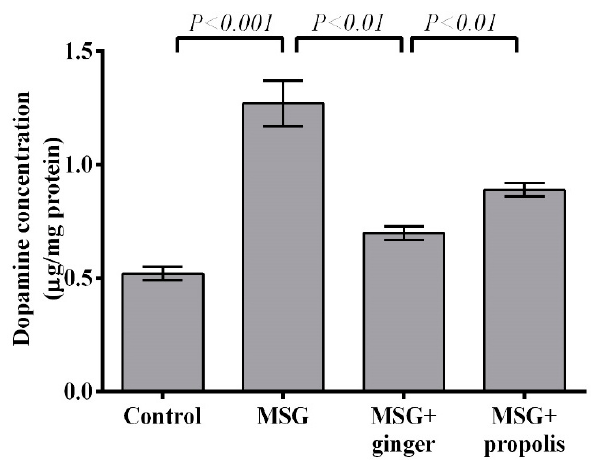
Figure 13. Cerebral cortex dopamine concentration at two months post-treatment. Data are expressed as mean ± SEM ( n = 6). Comparisons were made between normal control and MSG control groups, and between MSG control and MSG plus ginger or propolis supplement groups as well.